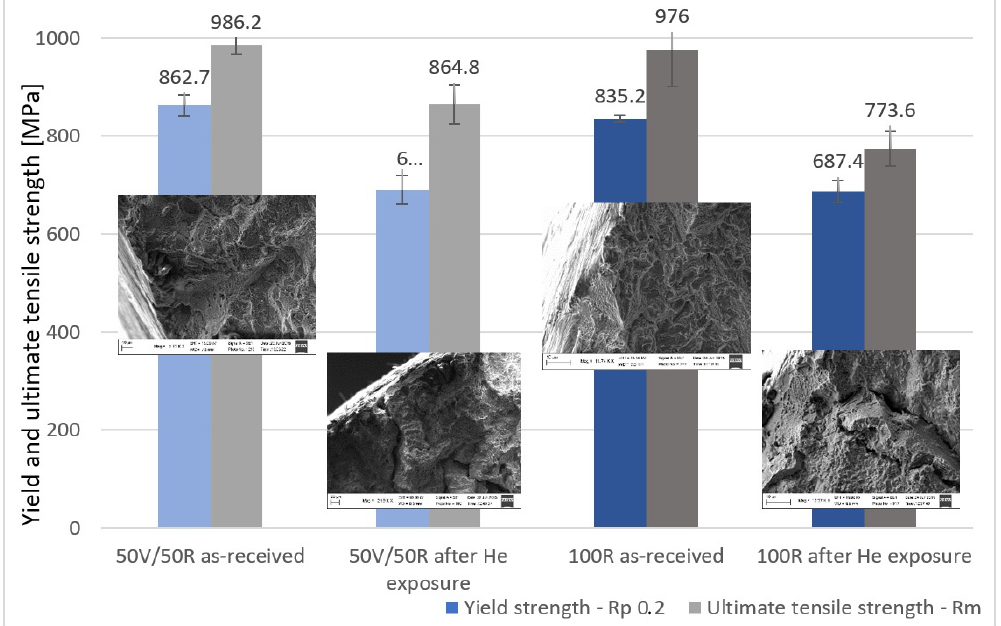
Figure 9. SEM–BSE image of IN738 100R after He exposure showing phases, layers and particles, with the composition identified by